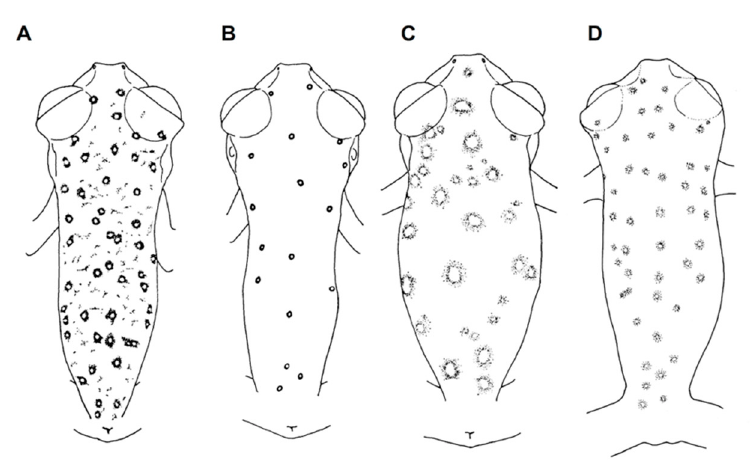
Figure 142. Dorsal patterns of ocellated glassfrogs, excluding Nymphargus laurae and N . lindae sp. nov. ( A ) N . anomalus , KU 143299. ( B ) N . cochranae , KU 121035. ( C ) N . ocellatus , LSU 25990. ( D ) N . ignotus , ICN 14750. Figure modified from Lynch and Duellman [22].